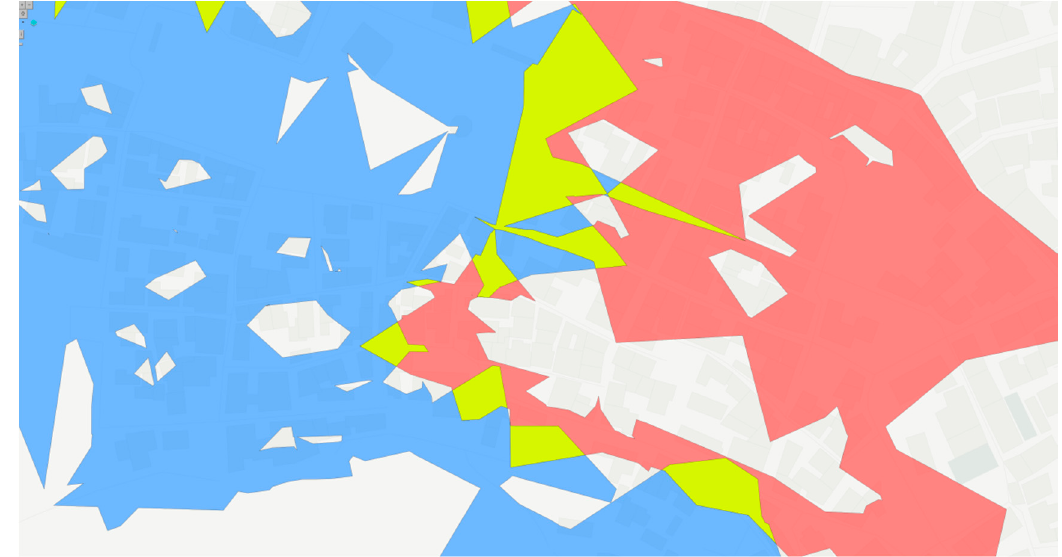
Figure 20. Highlight of the overlapping observation areas by different users.